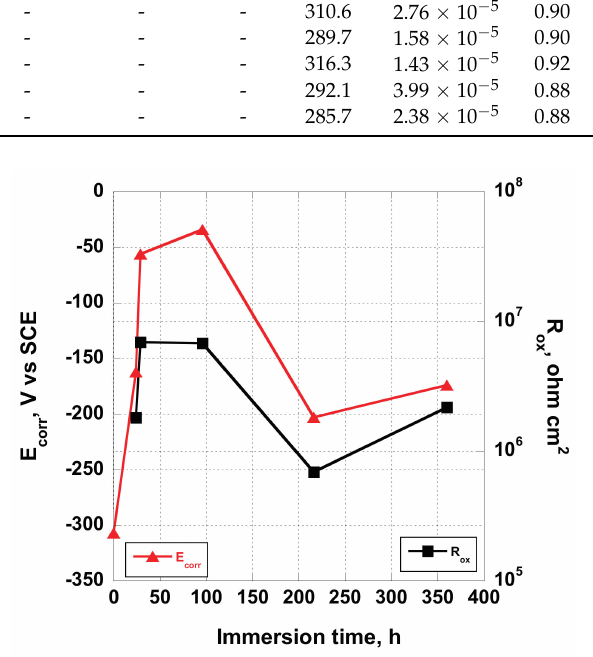
Figure 11. Variation of E corr and R ox as a function of time of immersion in Hank’s solution displayed by the AS